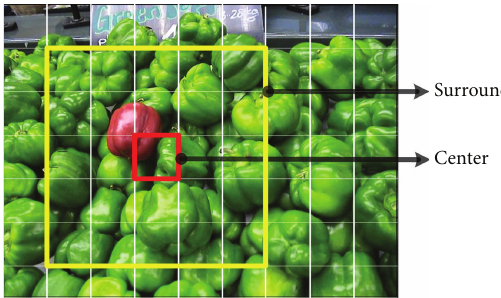
Figure 1: A depiction of center surround difference, where the patch in consideration is in red rectangle and the patches in yellow rectangular region are surrounding area from which the dissimilarity is